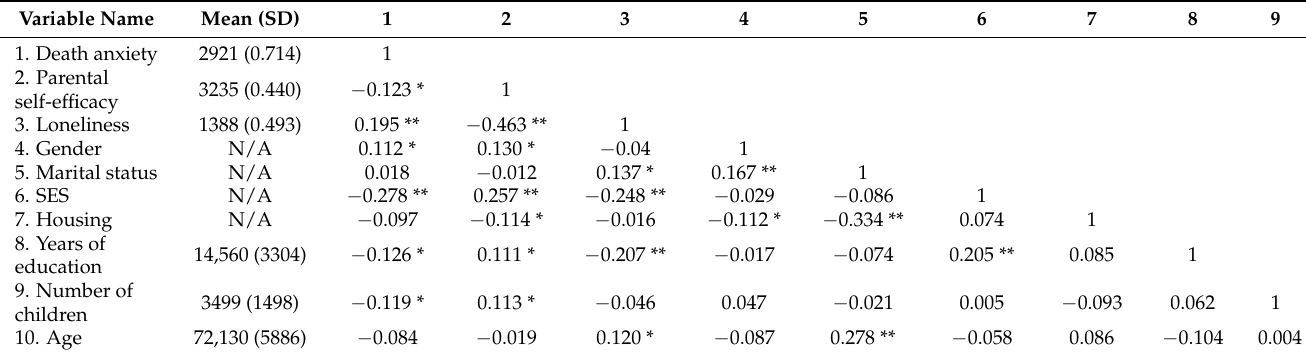
Table 1. Correlation coefficients between the study’s